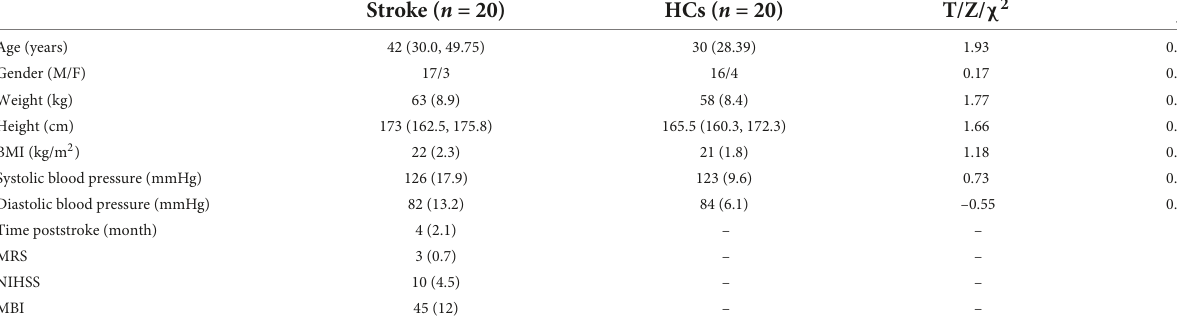
TABLE 1 Characteristics comparison between stroke group and HCs.